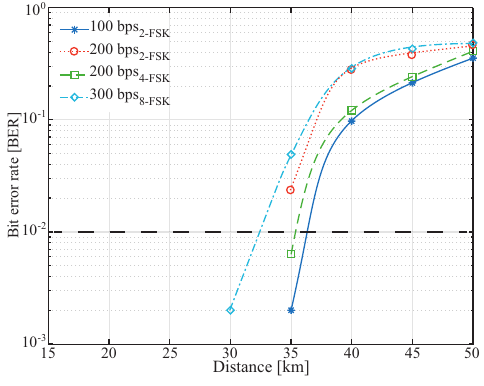
Figure 9. Bit error rate (BER) as a function of the transmission